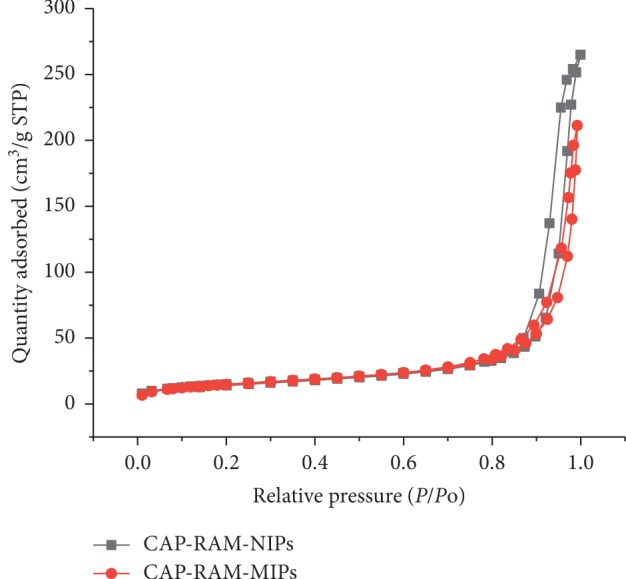
N2 adsorption of CAP-RAM-MIPs and CAP-RAM-NIPs.